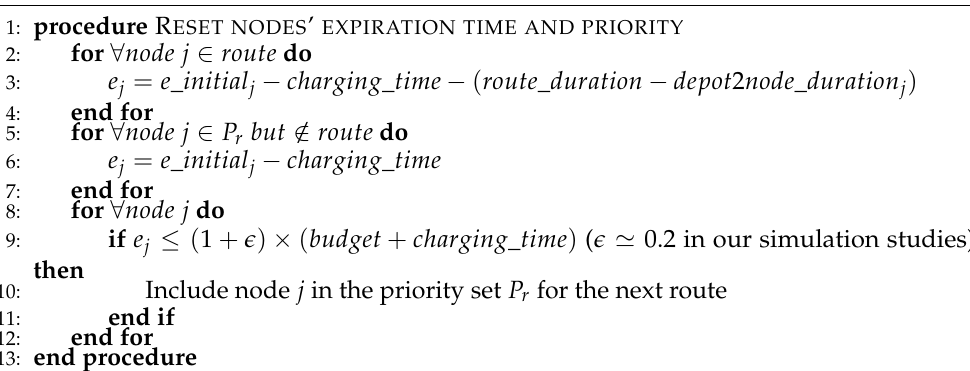
Algorithm 3 Reset nodes’ expiration time and priority function